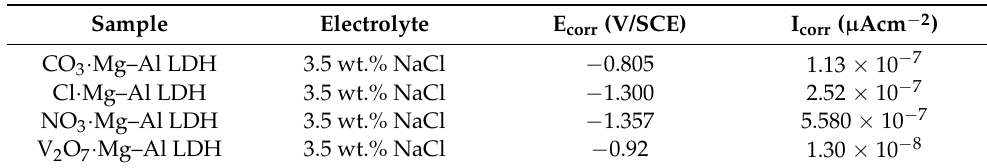
Table 1. Corrosion potential (E corr ), corrosion current density (I corr ) of the samples in 3.5 wt.% NaCl